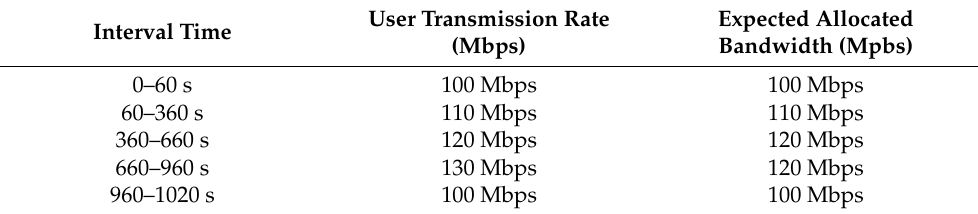
Figure 8. Real-time evolution of the requested bandwidth for the residential user that contract the basic flexible Internet plan. Table 2. Demanded and received bandwidth for the basic flexible Internet plan. Table 2. Demanded and received bandwidth for the basic flexible Internet